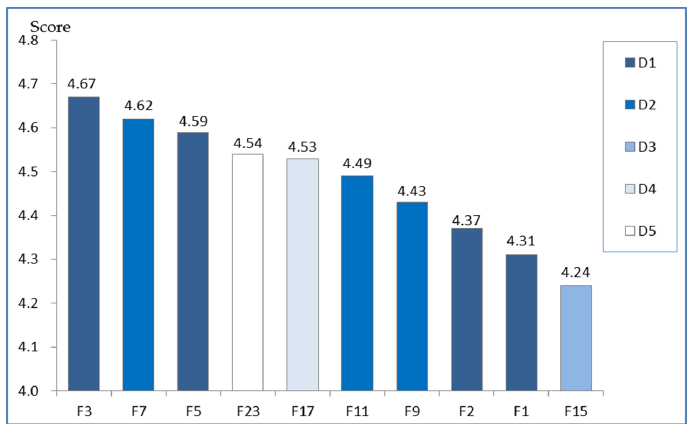
Figure 2. The top ten ranked factors through questionnaire survey analysis.